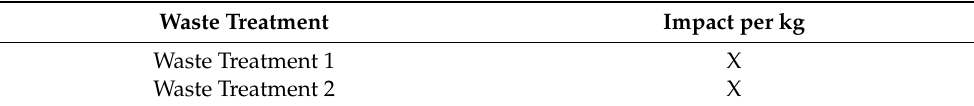
Table 3. Environmental impact of waste